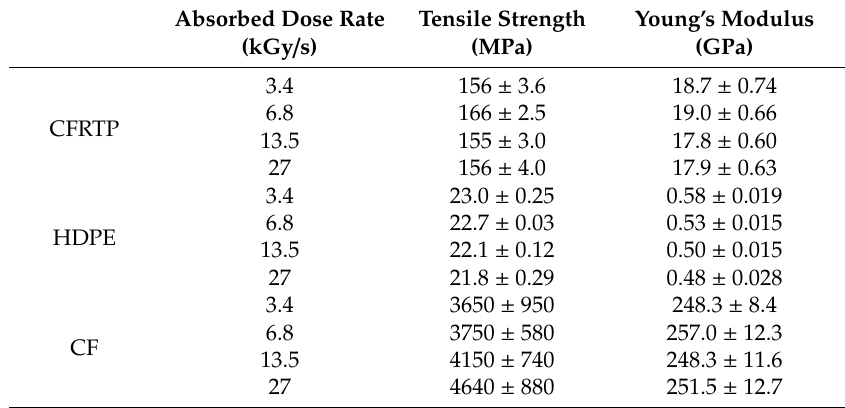
Figure 1. ( a ) TS and ( b ) YM of CFRTP, HDPE, and CF irradiated at various absorbed dose rates. Table 1. Tensile strength and Young’s modulus of CFRTP, HDPE, and CF irradiated at various absorbed dose rates.